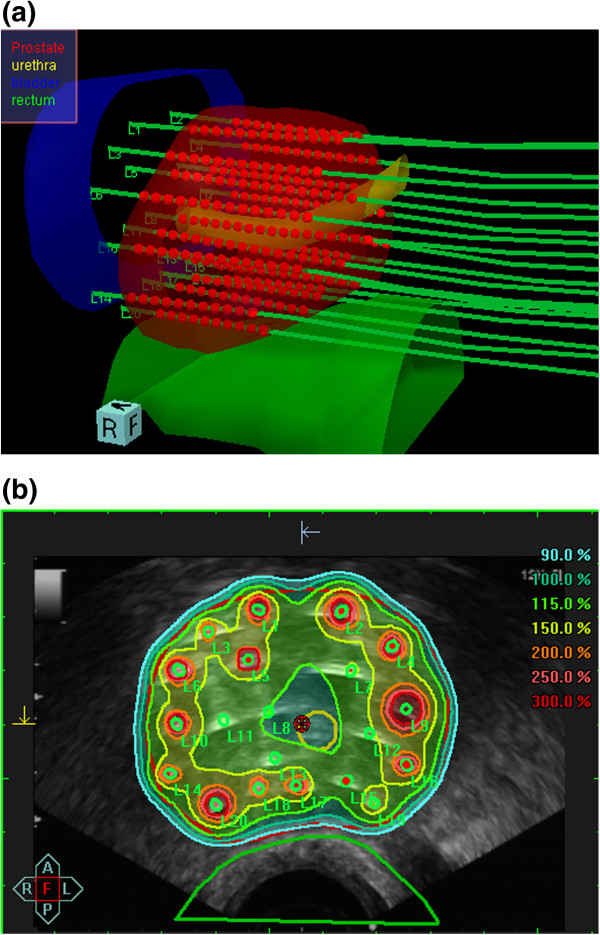
Intraoperative real-time treatment planning. (a) Three-dimensional reconstruction of the prostate, organs at risk (i.e., rectum, urethra, bladder), in situ needles and the intraprostatic source dwell positions as calculated using SWIFT for the final treatment plan. Contour definition for rectum extended 10 mm cranially from the prostatic base and 10 mm caudally from the prostatic apex. Urethra contouring encountered the intraprostatic urethra marked by the insertion of a three-way Foley catheter and extended by 5 mm caudally to include the apical urethra membrane. (b) Isodose distribution after anatomy-based dose optimisation. The isodose colour code convention is: dark red = 300% {isodose = 28.5 Gy}; orange = 200% {isodose =19.0 Gy}; yellow = 150% {isodose = 14.25 Gy}; turquoise = 100% {isodose = 9.5 Gy}. The 100% isodose was set to encompass the red delineated prostate capsule.